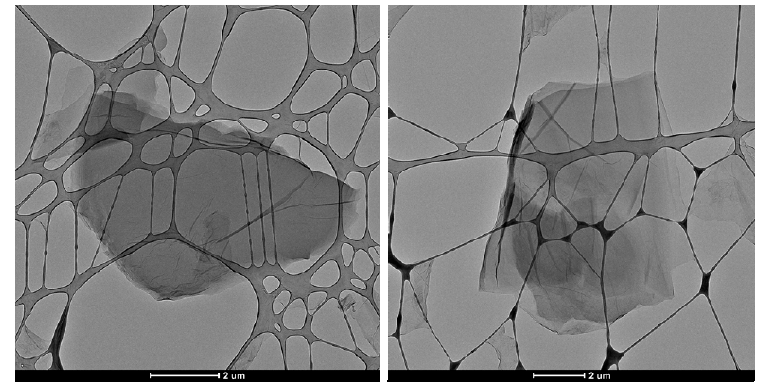
Figure 2 . TEM (transmission electron microscopy) images for synthesized GO flakes. The grid matrix seen is part of the support structure holding the GO sample.